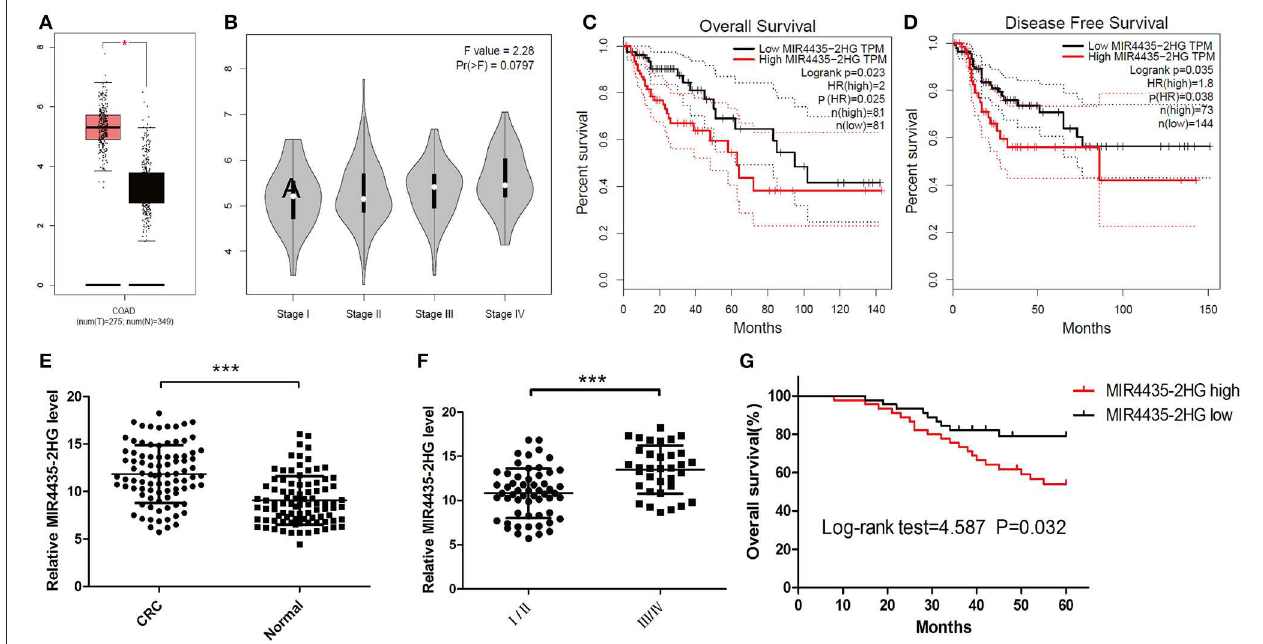
FIGURE 1 | The expression and prognosis of long non-coding RNA (lncRNA) MIR4435-2HG of colorectal cancer (CRC) in The Cancer Genome Atlas (TCGA) database and clinical specimens. (A) Gene Expression Profiling Interactive Analysis (GEPIA) of CRC data in TCGA show lncRNA MIR4435-2HG’s expression state in colon adenocarcinoma (COAD) and normal tissue. (B) The lncRNA MIR4435-2HG expression levels at different stages of COAD. (C,D) The impact of different expression levels of lncRNA MIR4435-2HG in overall survival and disease-free survival in COAD. (E) Comparison of lncRNA MIR4435-2HG in CRC tissues ( n = 45) and normal tissues ( n = 90). (F) LncRNA MIR4435-2HG expression at different TNM stages of CRC. (G) Kaplan Meier survival estimates of the correlations between lncRNA MIR4435-2HG expression and general survival of 90 cases with CRC shown in (E) . * P < 0.05, *** P < 0.001.